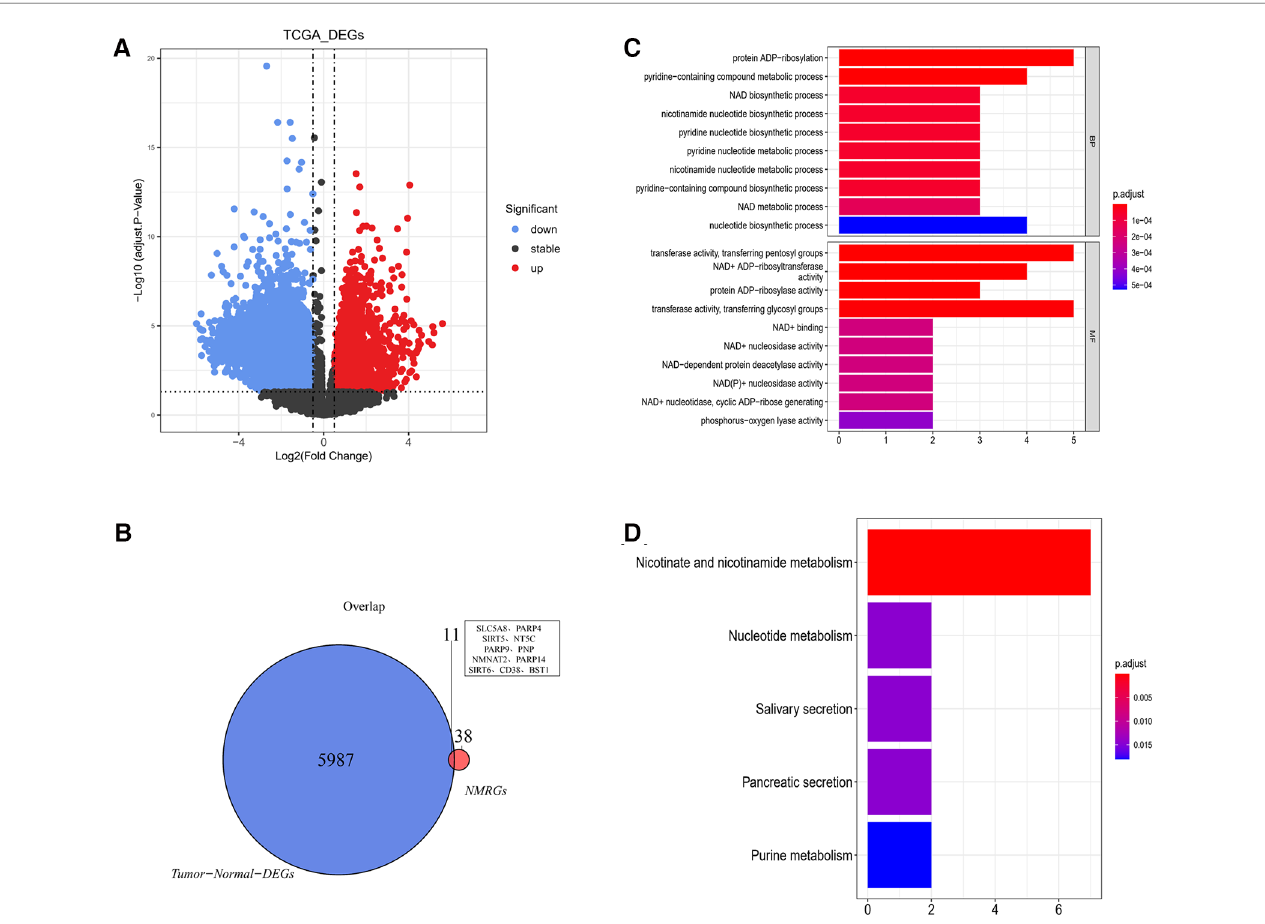
FIGURE 2 NAD+ metabolism-related differentially expressed genes were selected from glioma database. ( A ) Volcano map of differentially expressed gene analysis (DEGs) between glioma and normal samples. The horizontal coordinate log2FC indicates the difference multiplicity and the vertical coordinate indicates the con fi dence level - log10(adj. Pvalue). Each point in the graph represents a gene, with blue and red points representing signi fi cantly differentially expressed genes. Red dots indicate that their gene expression was up-regulated in the glioma samples and blue dots indicate that the gene was down- regulated in the glioma samples. ( B ) Venn diagram of differentially expressed genes with NMRGs. ( C,D ) Bar graphs of Gene ontology (GO) analysis and Kyoto Encyclopedia of Genes and Genomes (KEGG) analysis for NMR-DEGs.